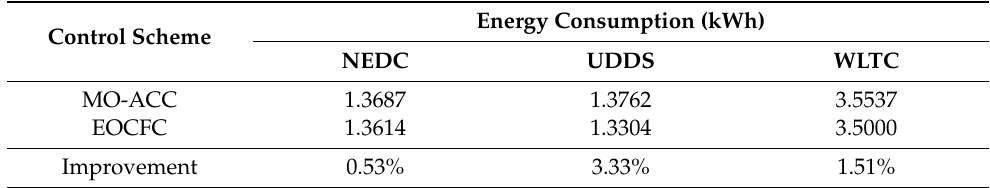
Table 2. Energy consumption under various test cycles (initial SOC =